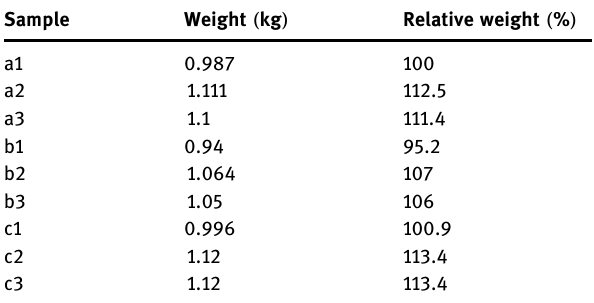
Table 6: Weight comparison of the samples Sample